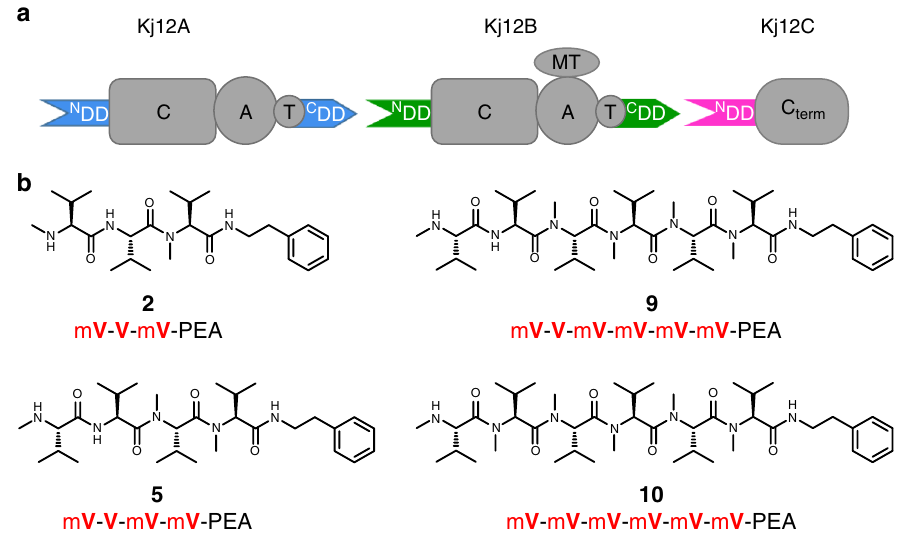
Fig. 1 RXP NRPSs (Kj12ABC) from Xenorhabdus stockiae KJ12.1 and selected RXPs found in this strain. a Overview of the domain organization of Kj12ABC (C condensation, A adenylation, MT methyltransferase, T thiolation, C term terminal condensation domain, N DD N-terminal docking domain, C DD C-terminal docking domain). b Structures of selected RXPs derived from the Kj12ABC system, showing differences in size and methylation patterns. The simpli fi ed structure nomenclature used within other fi gures is also shown (V Val, mV N -methylated Val, PEA